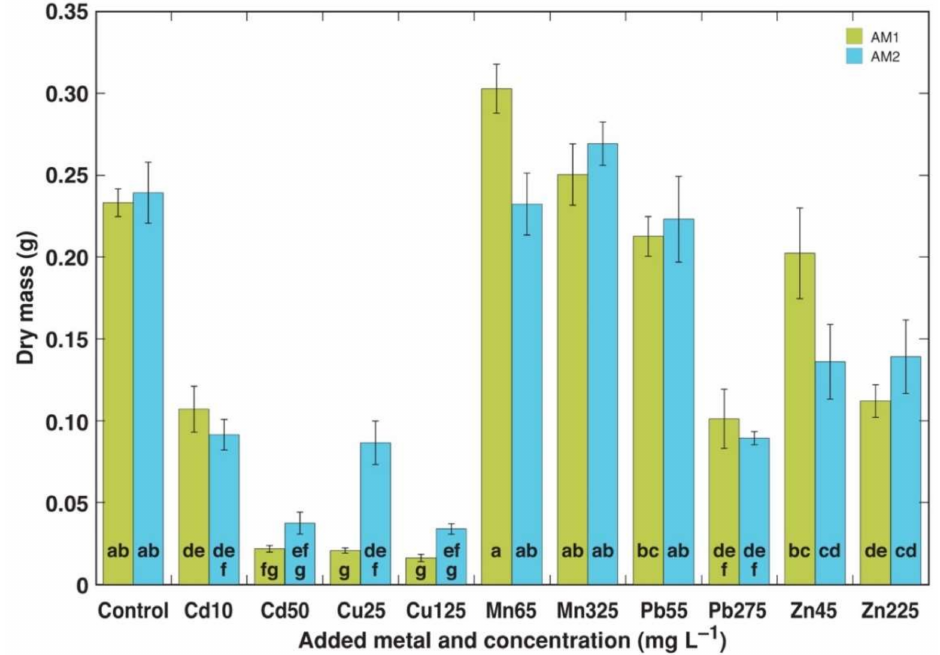
Figure 1. Effect of heavy metals on dry mass of plantlets of Armeria maritima accessions AM1 and